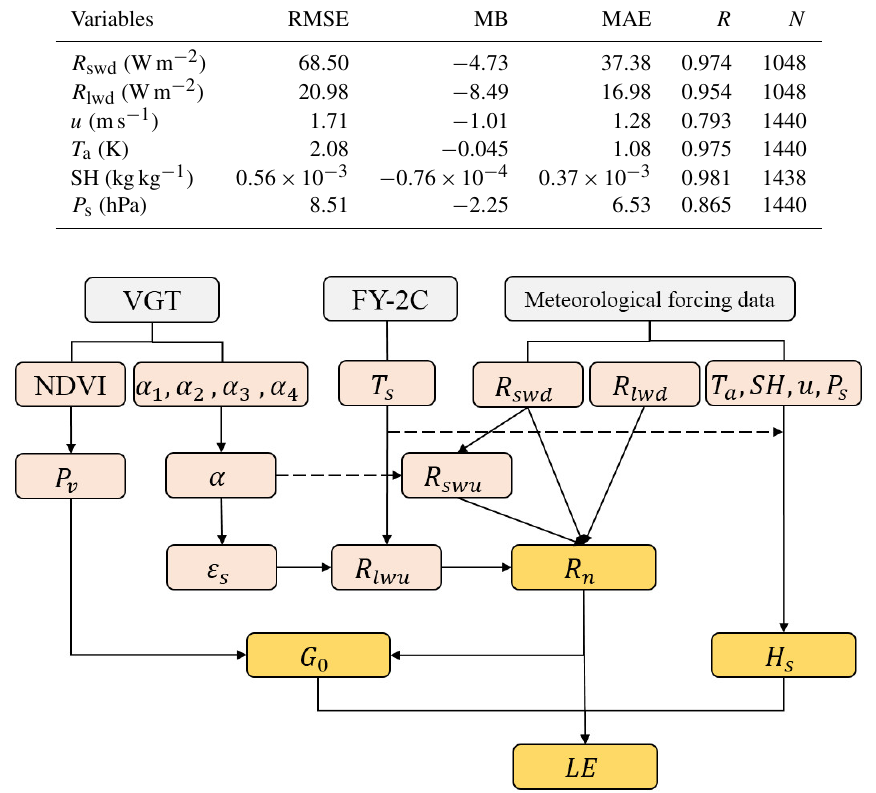
Figure 2. Flow chart of the flux estimation method to determine the net radiation flux, sensible heat flux and latent heat flux by combining VGT, FY-2C and meteorological forcing